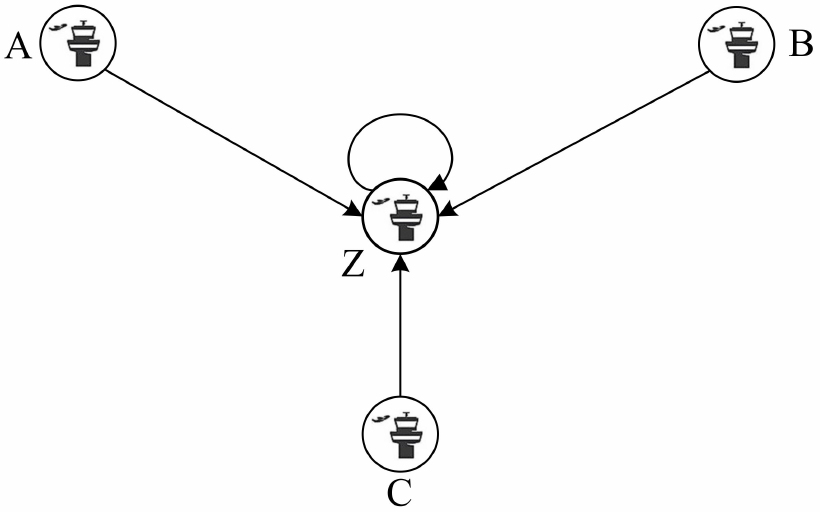
Figure 3. Diagram of confounding causality. Airport A, airport B, and airport C are the “cause” airports of airport